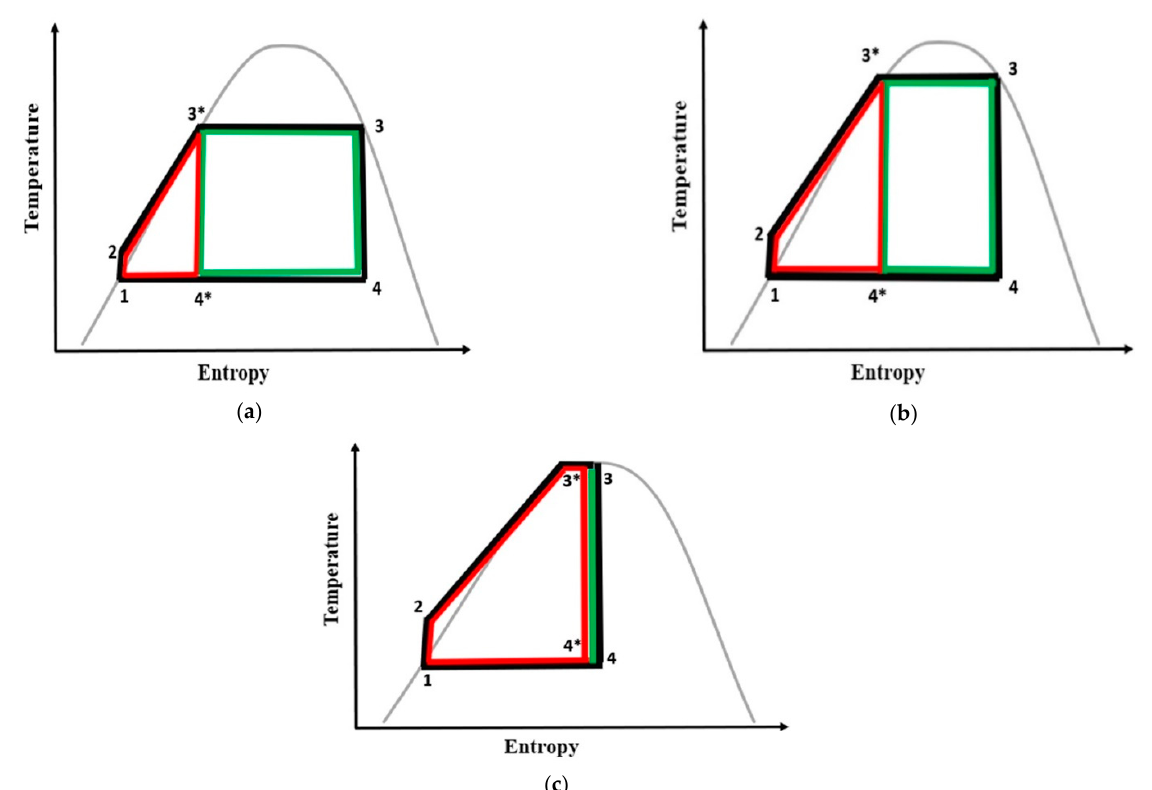
Figure 7. Rankine-cycle (black) in a wet working fluid as a superposition (but not the simple sum) of a TFC-like (red) and Carnot-like (green) parts with same condenser temperature with a medium ( a ) high ( b ) and almost critical ( c ) evaporator temperature.